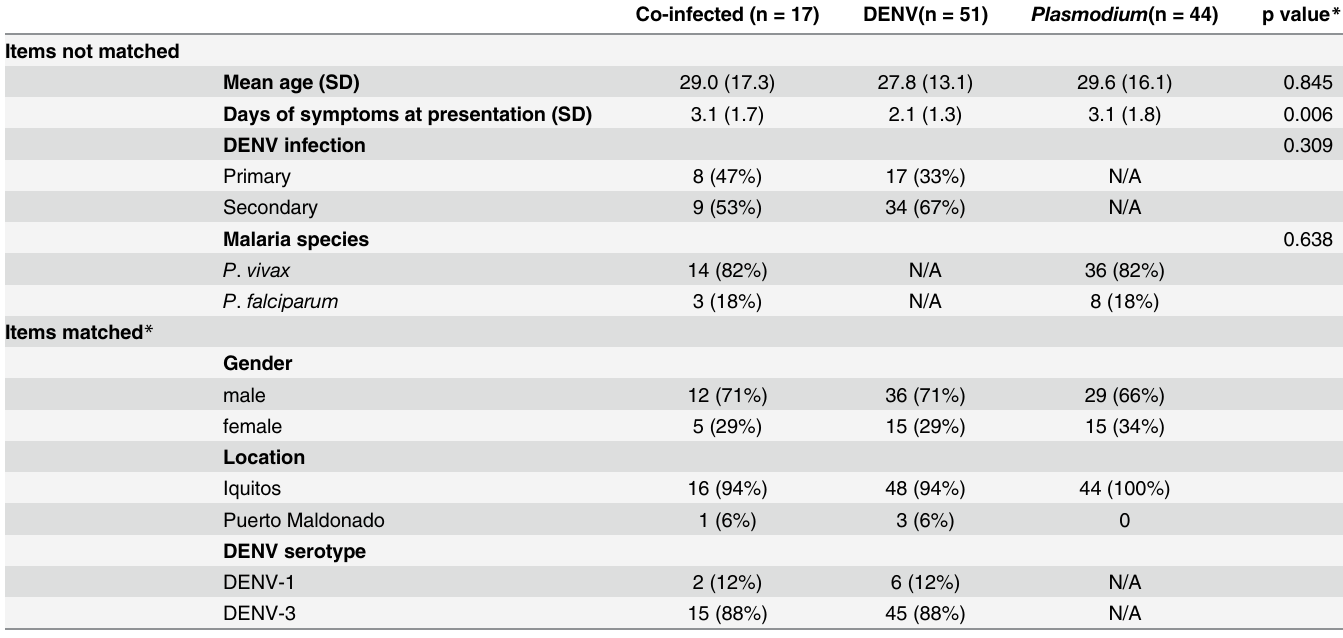
Table 2. Characteristics of the co-infected, dengue virus mono-infected, and Plasmodium mono-infected